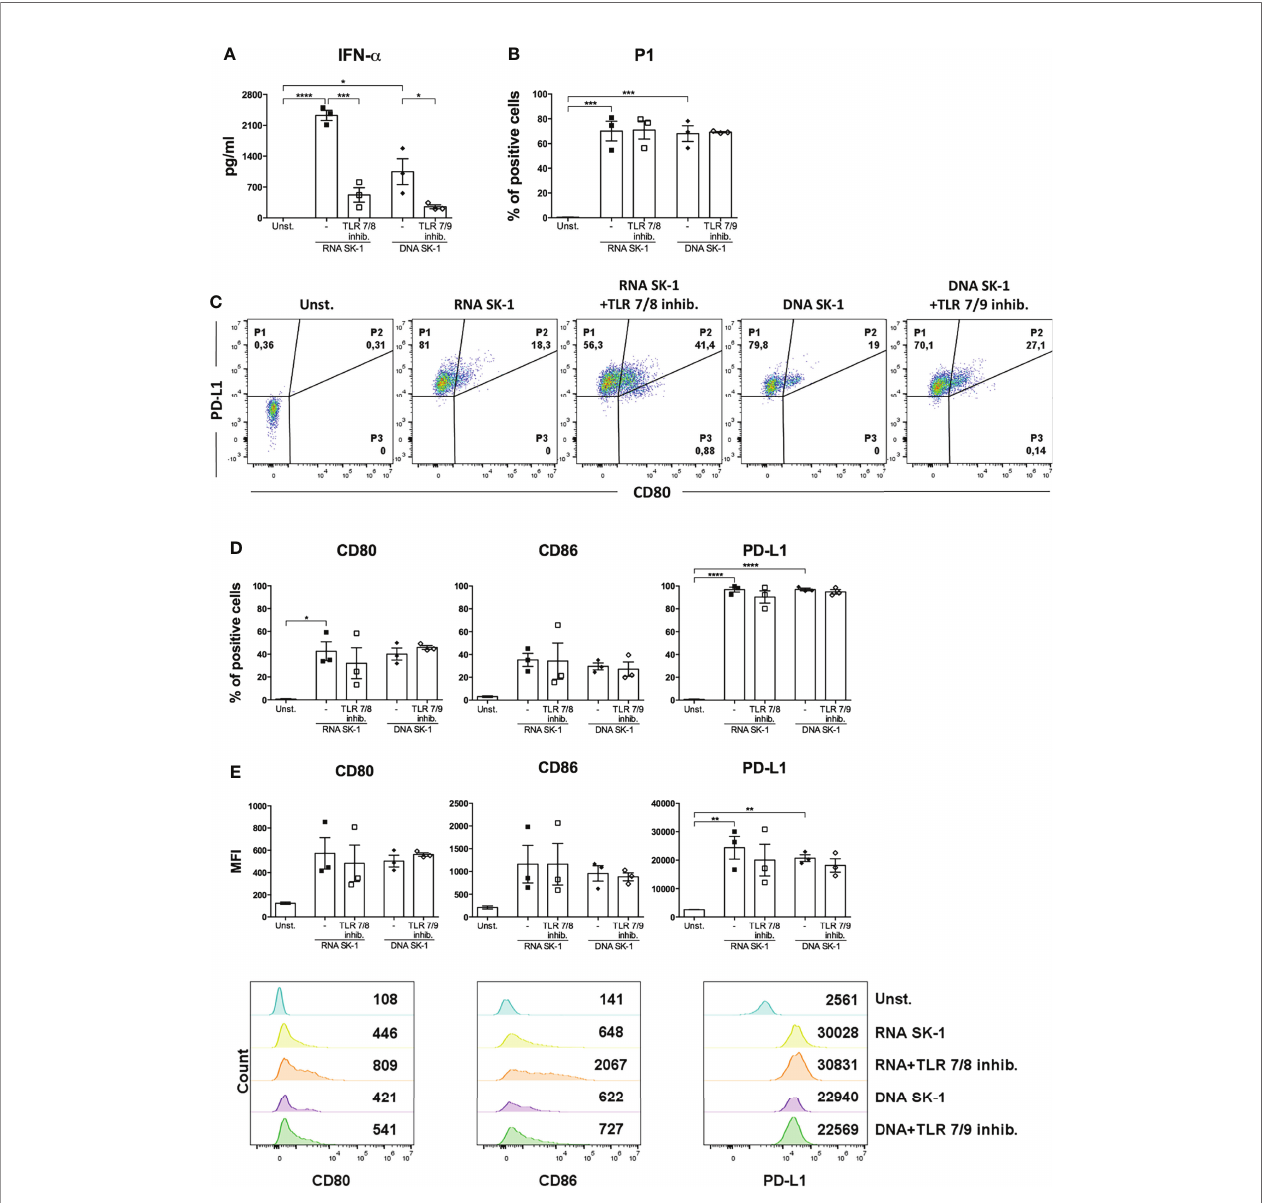
FIGURE 5 | IFN- a production by human plasmacytoid dendritic cells (pDCs) stimulated with SK-1 nucleic acids is partially mediated by TLR7 and TLR9. Human pDCs puri fi ed from the peripheral blood of healthy donors were pre-treated for 30 min with TLR7/8 (1 m M) or with TLR7/9 (1 m M) and cultured for 48 h with RNA or DNA (0.2 m g) after incubation with Dotap (10 m l/ m g of nucleic acids) for 30 min at 37°C without stimulation (Unst.). The levels of IFN- a were measured in the culture supernatants by ELISA (A) . The percentage of the P1-pDC subpopulation was evaluated by fl ow cytometry (B, C) . The percentages and median fl uorescence intensity of costimulatory molecules CD80, CD86, and PD-L1 were analyzed by fl ow cytometry (D, E) . The graphs show the mean ± SEM of three independent experiments, each from different donors. Two-way ANOVA was used to compare different experimental conditions (*= p -value ≤ 0.05; **= p -value ≤ 0.01; ***= p -value ≤ 0.001; ****= p -value ≤